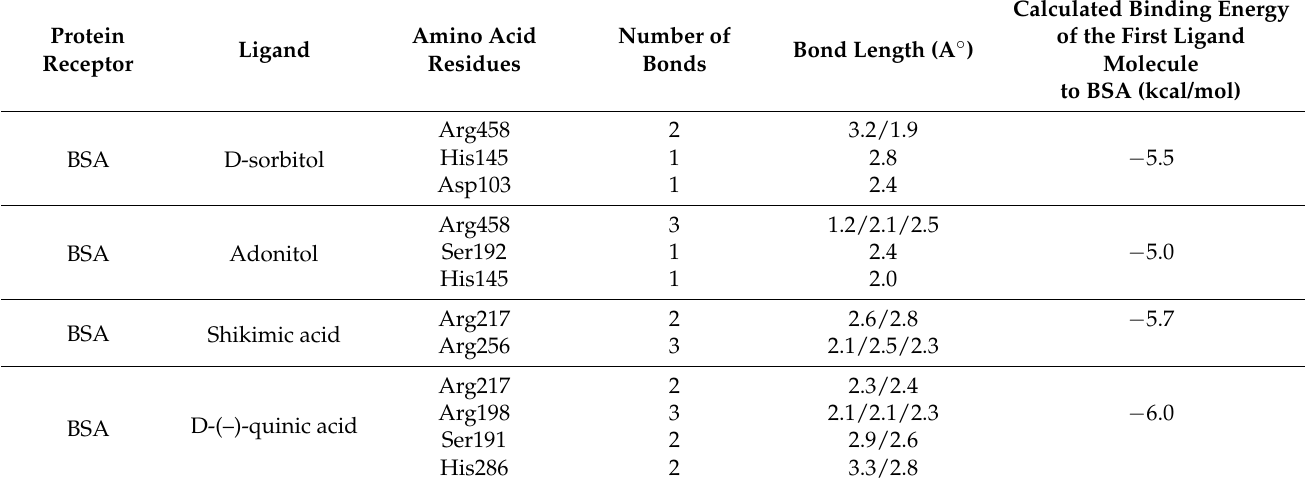
Table 4. Predicted cyclitol binding sites and calculated binding